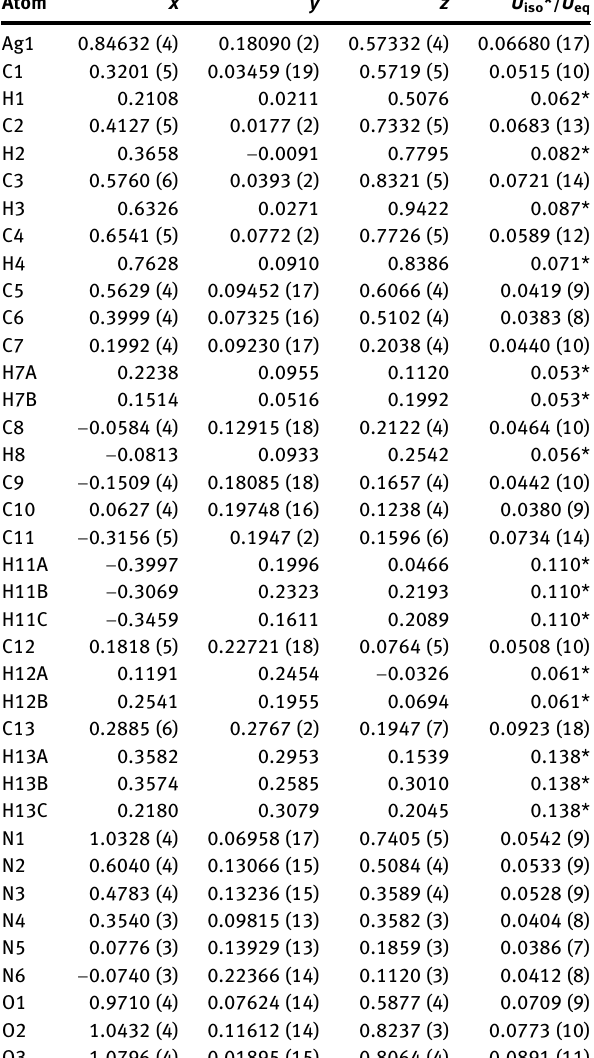
Table  : Fractional atomic coordinates and isotropic or equivalent isotropic displacement parameters (Å  ). Atom U iso */ U